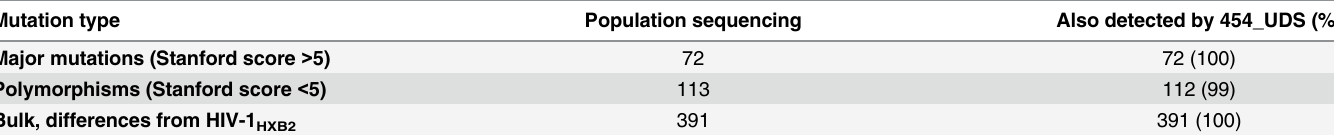
Table 3. Concordance between amino acid mutations detected by population and ultra-deep pyrosequencing. Included in the analysis were all non- redundant RTP samples (1 – 9, 19 – 27, 37 replicate #2, 38 replicate #2, and 39 replicate #2). Mutation type Population sequencing Also detected by 454_UDS (%) Major mutations (Stanford score >